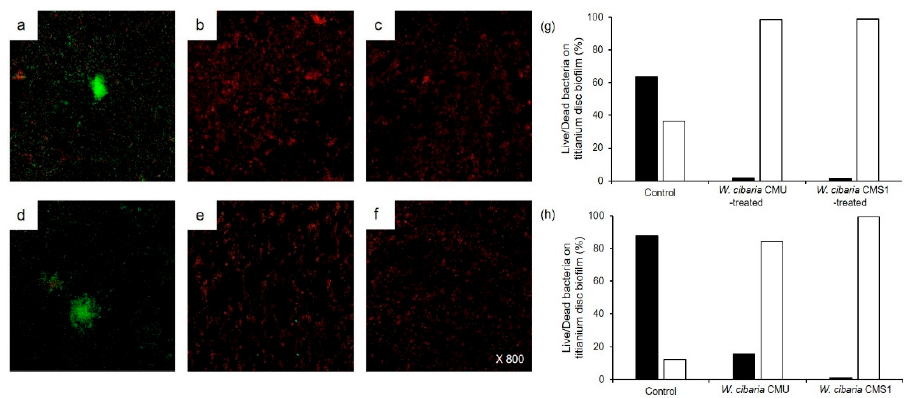
Figure 7. CLSM analysis of multi-species implant biofilms on titanium discs with ( a – g ) machined or ( d – h ) SLA surface. ( a , d ) Control; ( b , e ) W. cibaria CMU-treated; ( c , f ) W. cibaria CMS1-treated. Magnification, 800 × . ( g ) Live/dead cell ratios on titanium discs with machined surface; ( h ) live/dead cell ratios on titanium discs with SLA surface. Black bar, live bacteria; white bar, dead bacteria.